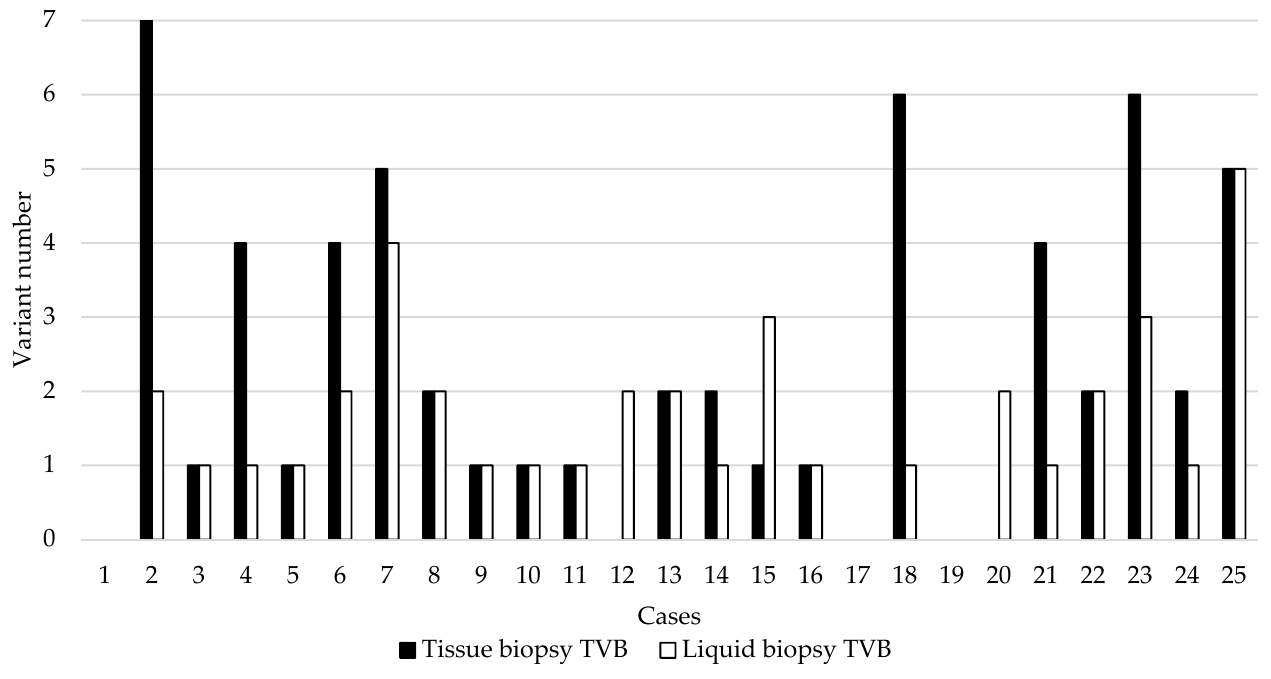
Figure 3. Tumor variant burden in the 25 BTC cases. TVB was defined with the number of gene variants including SNPs above 2% VAF. Table 3. Detected single-nucleotide variants.